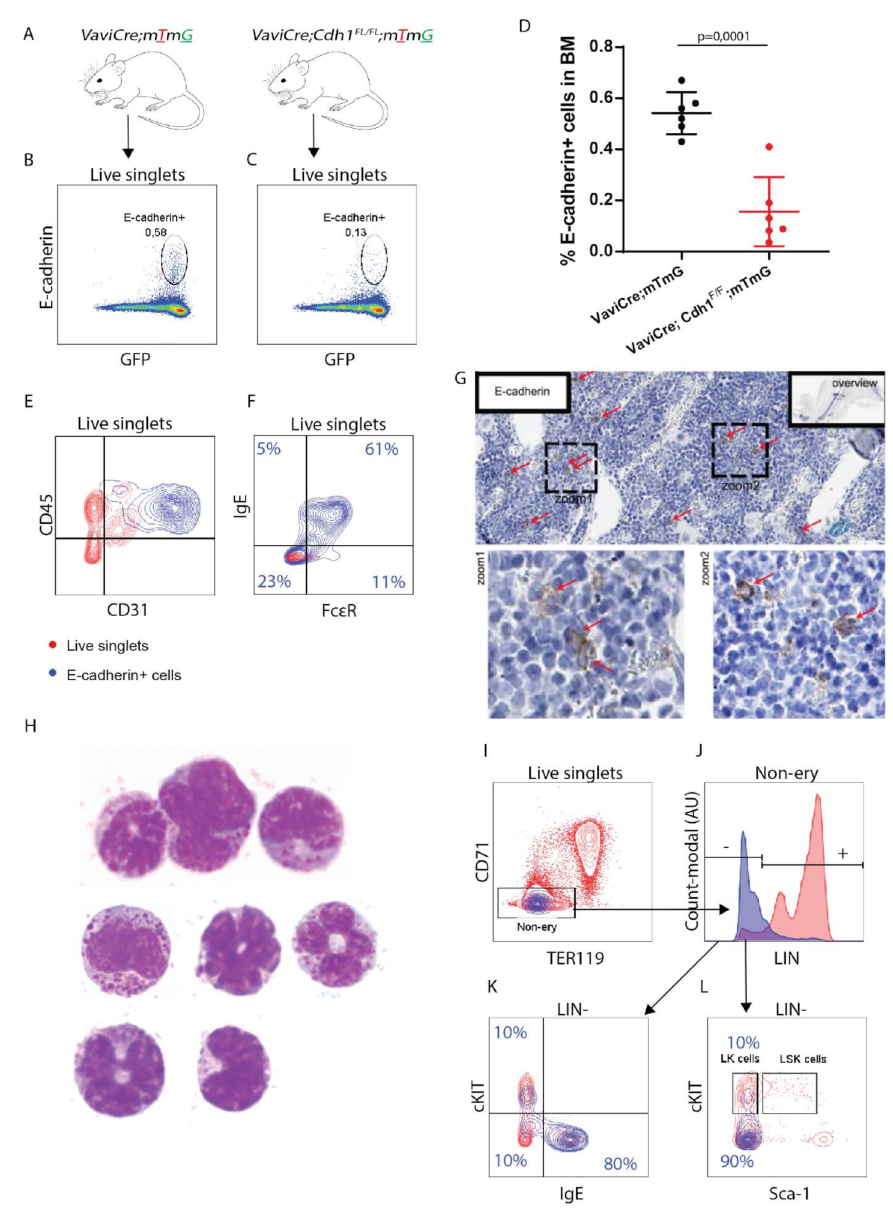
Figure 1. E-cadherin is sporadically expressed in the mouse hematopoietic cell lineage. ( A ) Schematic illustration of hematopoietic-specific E-cadherin ( Cdh1 ) KO and control mouse models. Vav-iCre